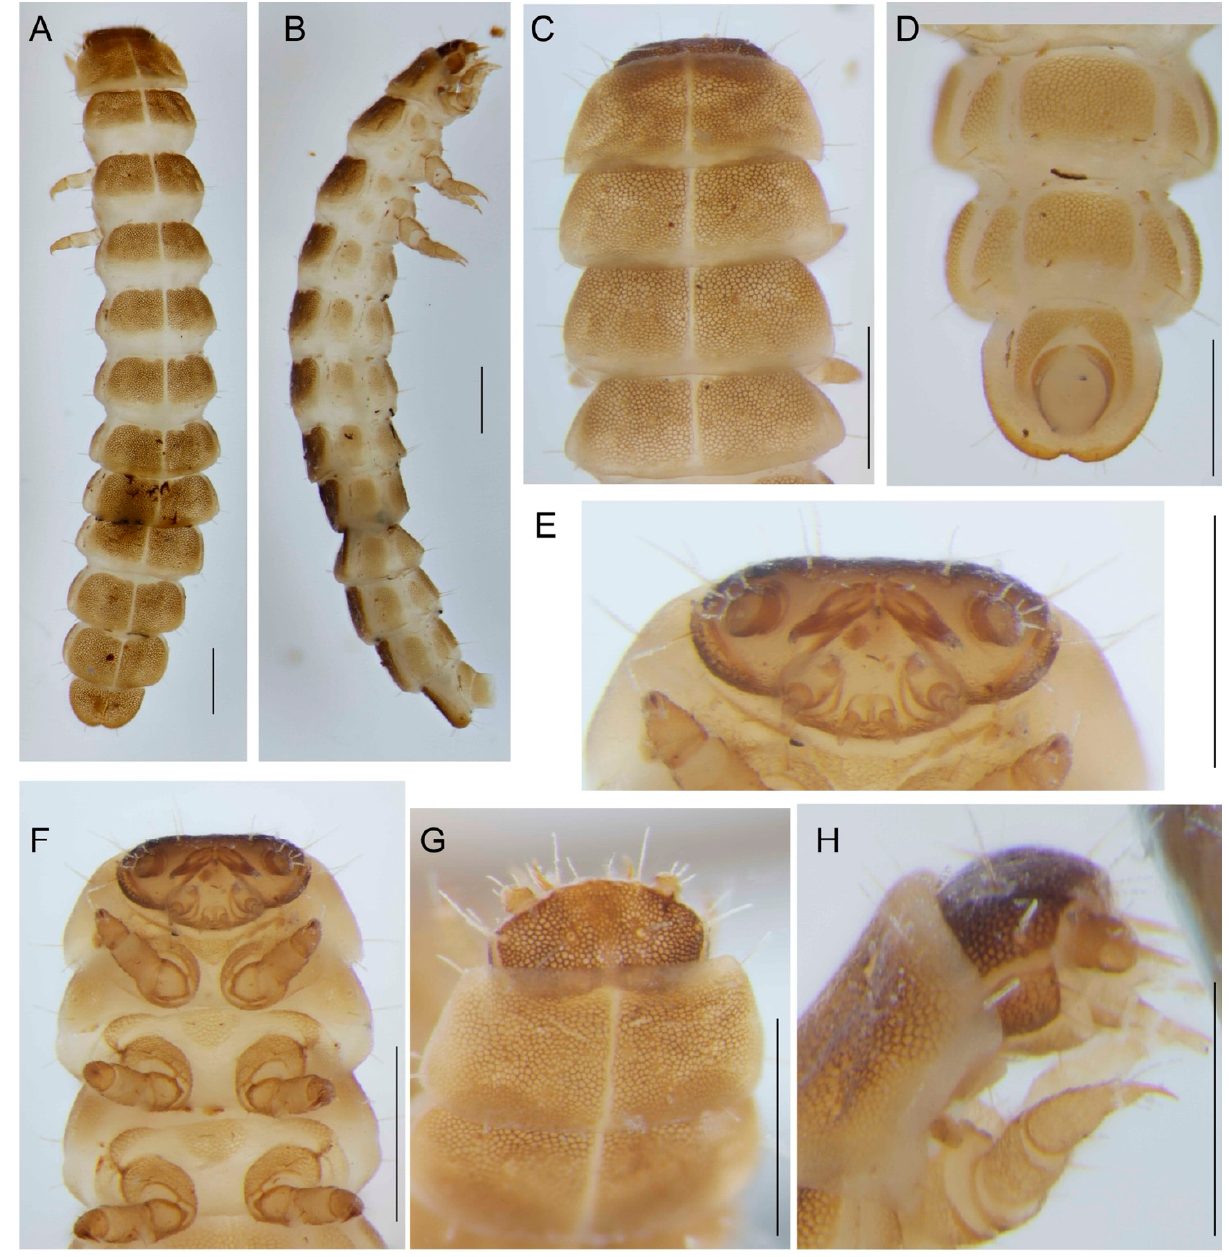
Figure 4. Dictyoptera aurora (Herbst), second instar larva, ( A ) dorsal view; ( B ) lateral view; ( C ) head, thorax, and abdominal segment 1, dorsal view; ( D ) terminal abdominal segments, ventral view; ( E ) head, frontal view; ( F ) head and thorax, ventral view; ( G ) head and pronotum, dorsal view; ( H ) ditto, lateral view. Scales 0.5 mm.